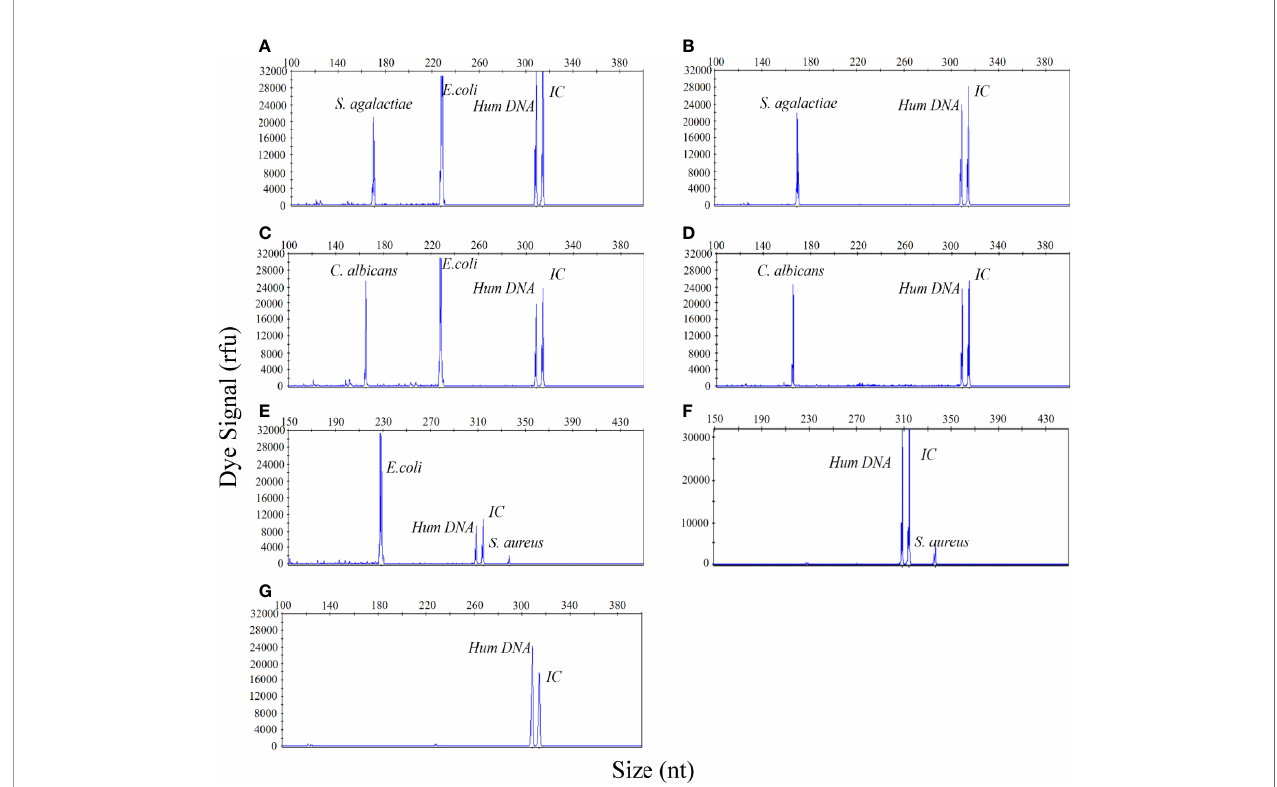
FIGURE 5 | The UTI-HMGS assay can simultaneously and quantitatively detect two pathogens in a simulated dual-infected urine specimen without in fl uence from the other pathogen. (A) A simulated dual-infected specimen of urine containing S. agalactiae (10 4 CFU/mL) and E. coli (10 5 CFU/mL). (B) A simulated urine sample featuring a single infection of S. agalactiae (10 4 CFU/mL). (C) A simulated dual-infected urine specimen containing C. albicans (10 4 CFU/mL) and E. coli (10 5 CFU/ mL). (D) A simulated urine sample featuring a single infection of C. albicans (10 4 CFU/mL). (E) A dual-infected urine specimen containing S. aureus (10 4 CFU/mL) and E. coli (10 5 CFU/mL). (F) A simulated urine sample featuring a single infection of S. aureus (10 4 CFU/mL). (G) A urine sample acquired from a healthy control without infection (negative